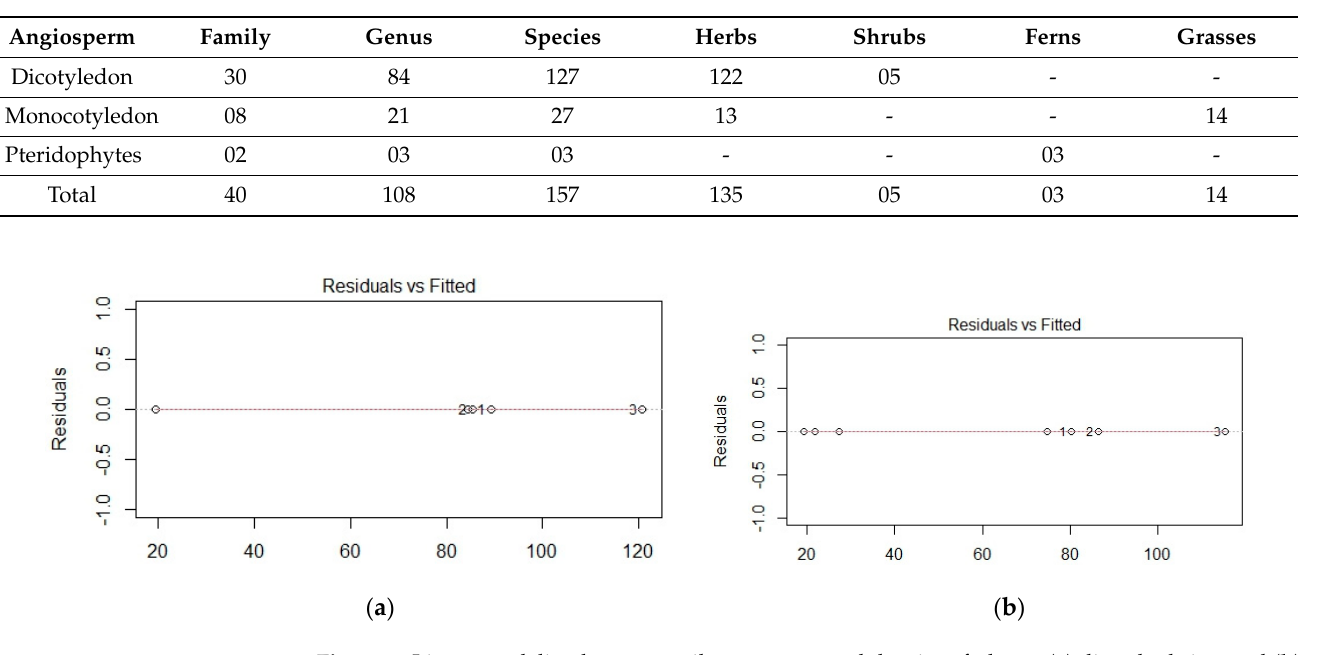
Table 1. Taxonomical description of surveyed plants.